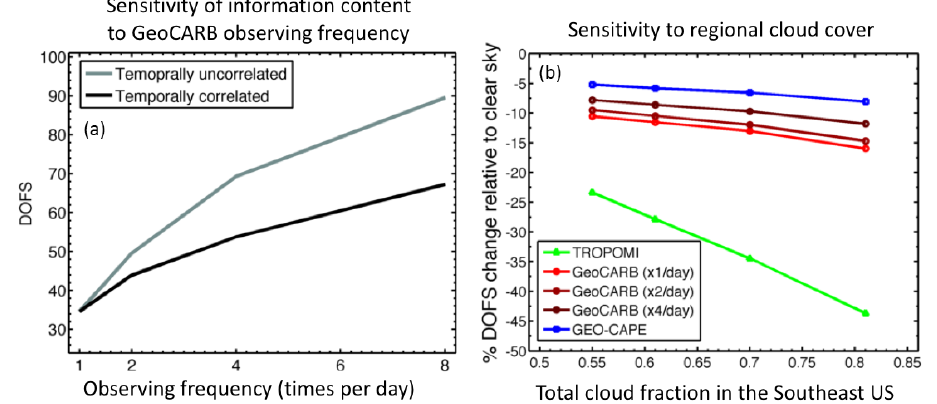
Figure 6. Effects of observing frequency and regional cloud cover on the information content (DOFS) from different satellite observing configurations in constraining methane emissions on the 25km scale. Panel (a) shows the sensitivity of the DOFS to observing frequency for the GeoCARB instrument, with and without accounting for temporal correlation in the model transport error ( e -folding timescale of 6h). Panel (b) shows the sensitivity of the DOFS to regional cloud fraction, as a percentage decrease relative to clear sky, using the combination of the GEOS-FP cloud cover data and clear-sky probabilities as a function of pixel size (Remer et al., 2012).